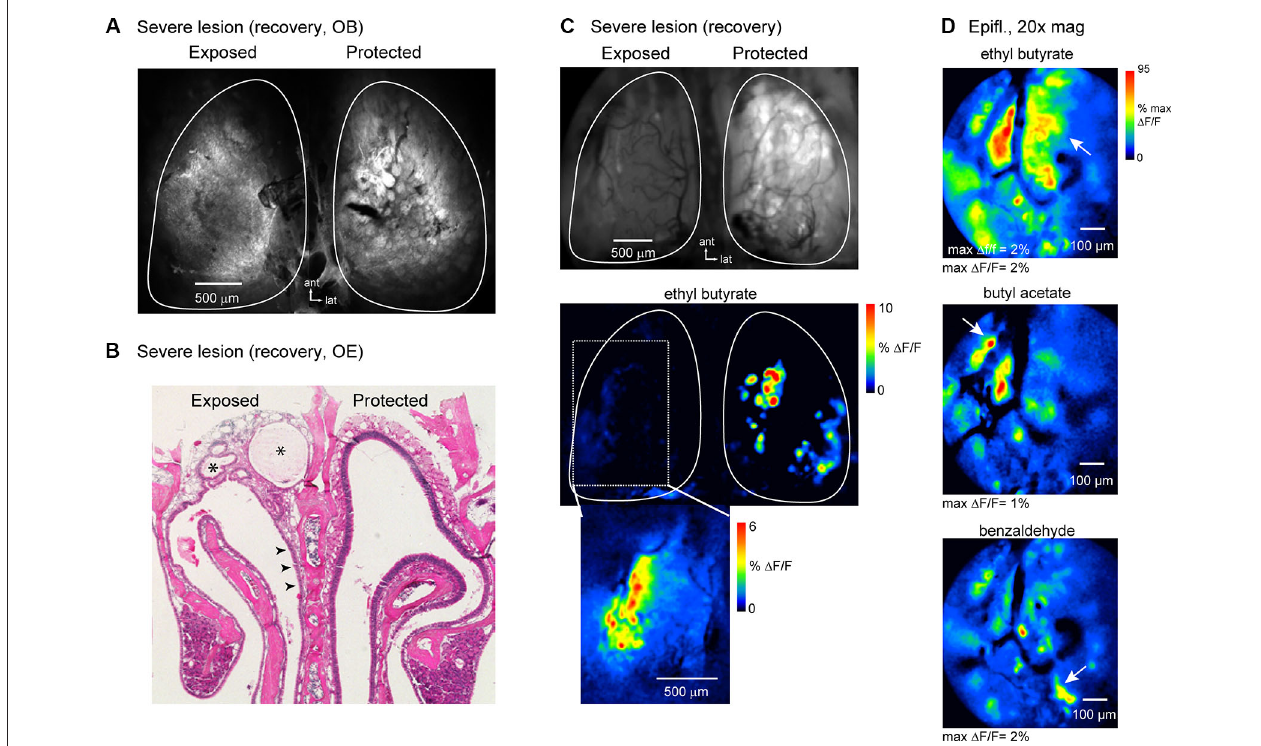
(A, B) imaged at the recovery stage. Resting fluorescence is low on the exposed side. Very weak odorant-evoked spH signals were detected on this side and were confined to the lateral margin of the dorsal OB ( bottom ). Inset shows evoked signals from this region after rotating the head for improved optical access and scaling responses in this region to their own maximum. (D) Response maps evoked by ethyl butyrate and two additional odorants imaged from the same animal at higher-magnification (20X objective) with wide-field optics. Multiple spH signal foci, nearly all of which are subglomerular in size, are evoked by each odorant, although the patterns of activation are distinct. Arrows indicate signal foci that appear specific for a given